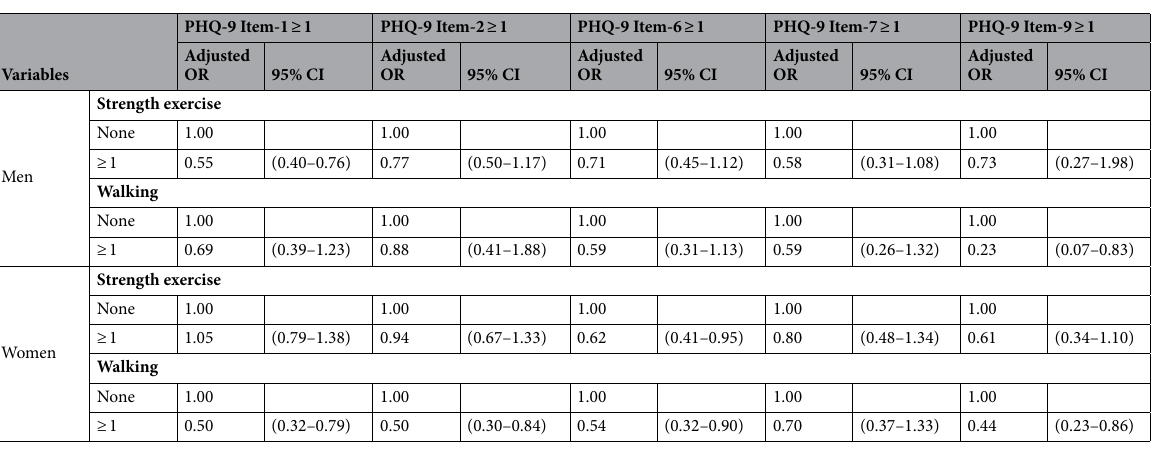
Table 6. Dependent subgroup analysis of the association among strength exercise , walking and cognitive/ affective items of PHQ-9. PHQ-9 patient health questionnaire-9, OR odds ratio, CI confidence interval.